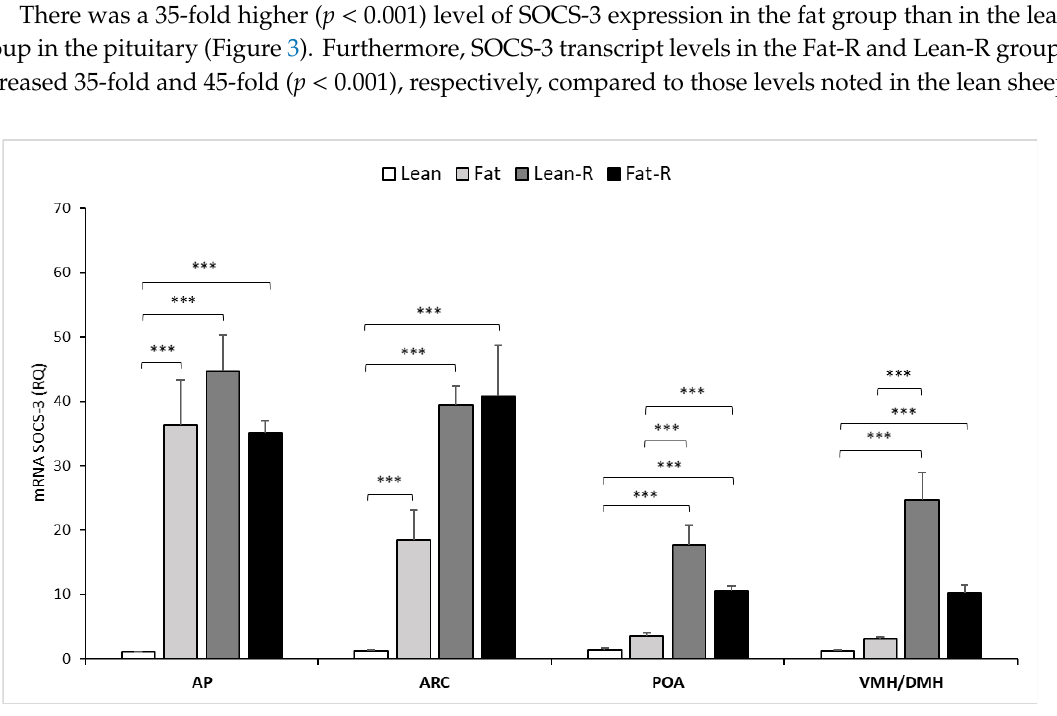
Figure 3. Expression of SOCS-3. The mean expression (±SEM) of a suppressor of cytokine signaling-3 (SOCS-3) mRNA in the ovine anterior pituitary (AP), arcuate nucleus (ARC), preoptic area (POA) and ventro- and dorsomedial nuclei (VMH/DMH) collected during long-day (LD) photoperiod in nontreated (Lean and Fat) animals and animals treated with recombinant bovine resistin (Lean-R [Lean-Resistin treated] and Fat-R [Fat-Resistin treated]. The expression of SOCS-3 mRNA is reported in arbitrary units (RQ) relative to cyclophilin mRNA and expressed relative to the calibrator sample. Differences relative to the control or between the other groups are indicated with ** p < 0.05 or *** p < 0.001.